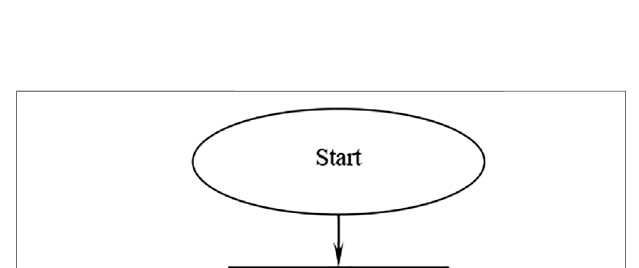
Frontiers in Energy Research |